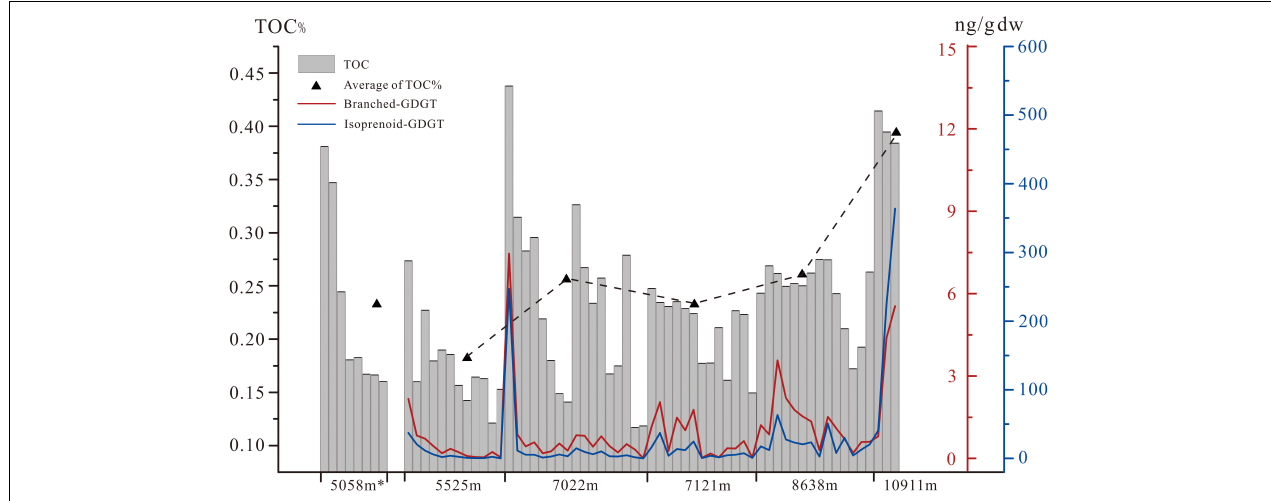
FIGURE 2 | Abundance of TOC and GDGTs from 5000-11000 m in Mariana/Yap Trenches. The distribution of TOC, BrGDGTs and IsoGDGTs (normalized to dry weight of sediment) in the trench sediments from Mariana and Yap Trench. (The asterisk represents the Yap sediment core S01; The mean value of TOC calculates from the subsamples of the first 20 cm of each sediment column). The concentration of IsoGDGT has been published on Chen et al., 2020.